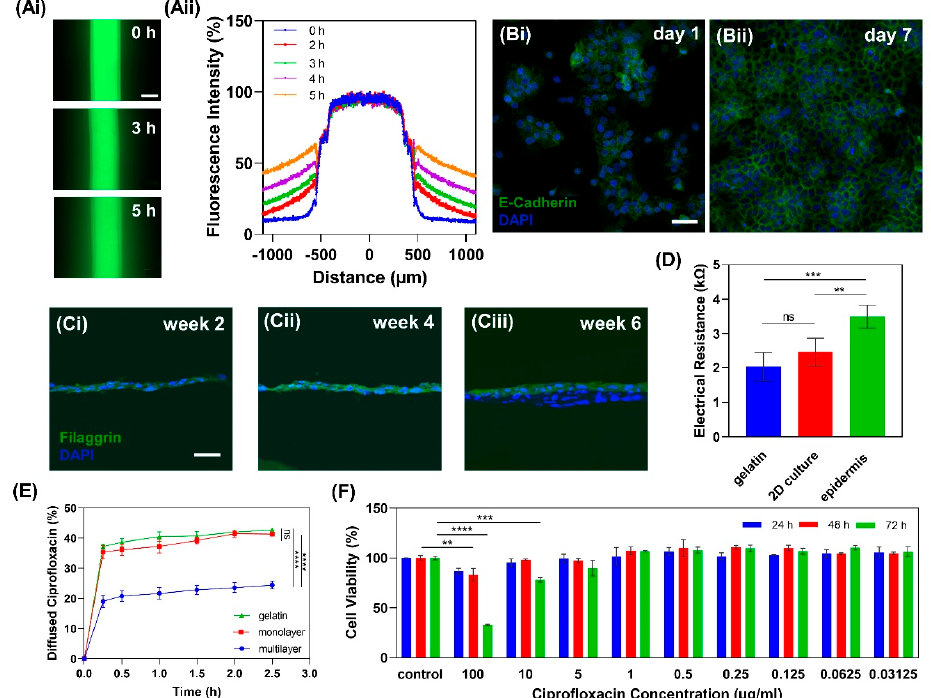
Figure 5. In vitro epidermis model characterization. ( A ) Fluorescein isothiocyanate–dextran (FITC-dextran, 70 kD) di ff usion through the channel to 20% gelatin, scale bar is 500 µ m. ( B ) Fluorescence image of immunocytochemical staining of E-cadherin (green) in HaCaT cell junctions and DAPI for nucleic staining (blue) on day 1 ( i ) and day 7 ( ii ) when cells reached confluency; scale bar is 50 µ m. ( C ) Fluorescence image of immunocytochemical staining of filaggrin protein (green, late di ff erentiation marker of HaCaT) and nuclei with DAPI (blue) in week 2 ( i ), 4 ( ii ), and 6 ( iii ); scale bar is 50 µ m. ( D ) Electrical resistance measurements (n = 5). ( E ) Ciprofloxacin di ff usion from the surface of 20% gelatin to the channel, indicating the barrier function of epidermis (n = 3). ( F ) The cytotoxic e ff ects of di ff erent concentrations of ciprofloxacin on HaCaT cells (n = 3). (Error bars indicate standard deviation. ns, **, ***, and **** indicate nonsignificant, p < 0.01, p < 0.001, and p < 0.0001,